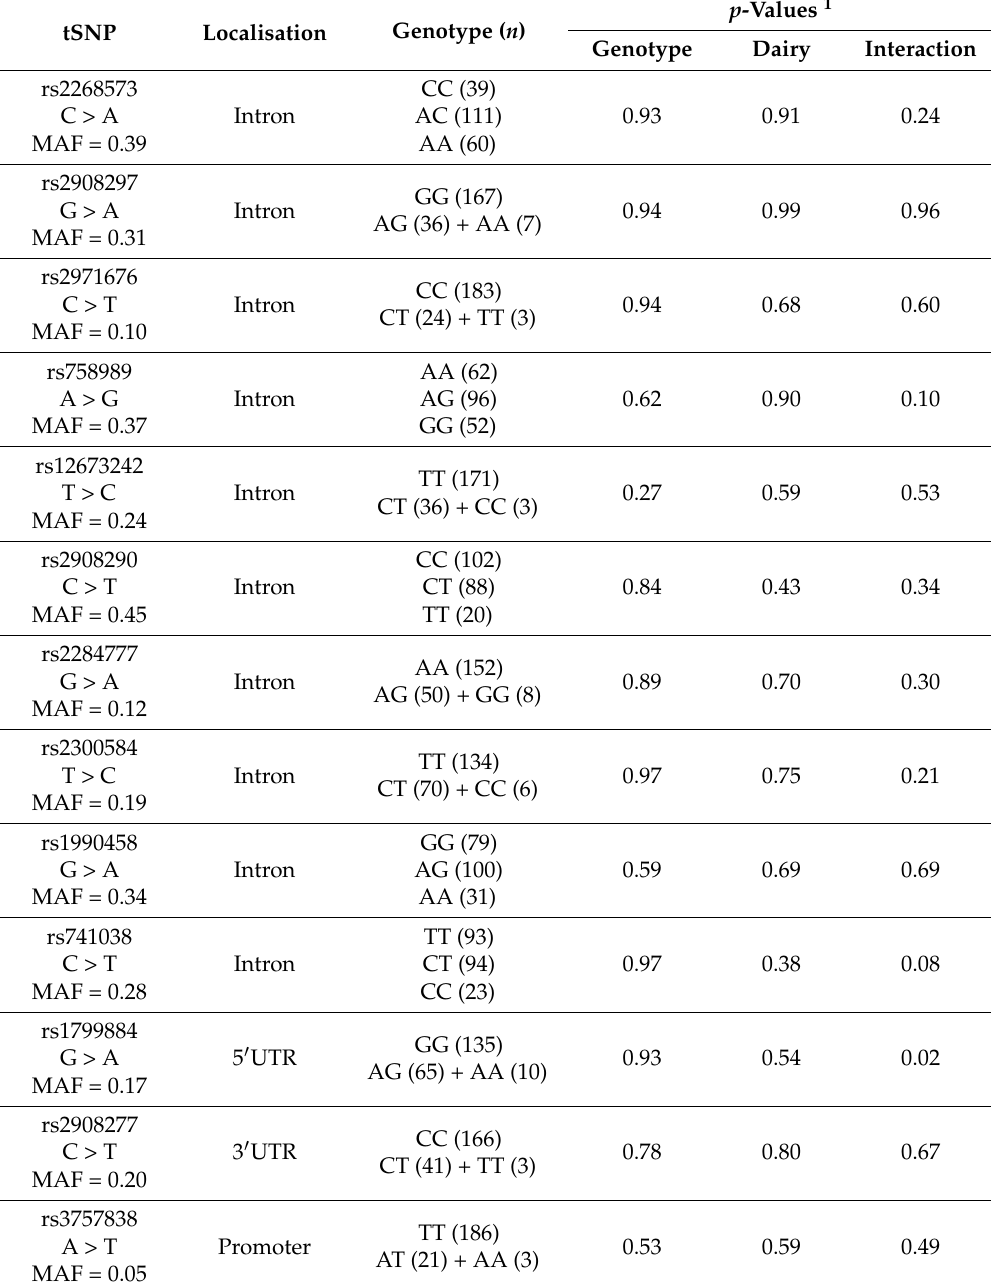
Table 1. Gene-diet interaction effects for total dairy intake on homeostasis model assessment of